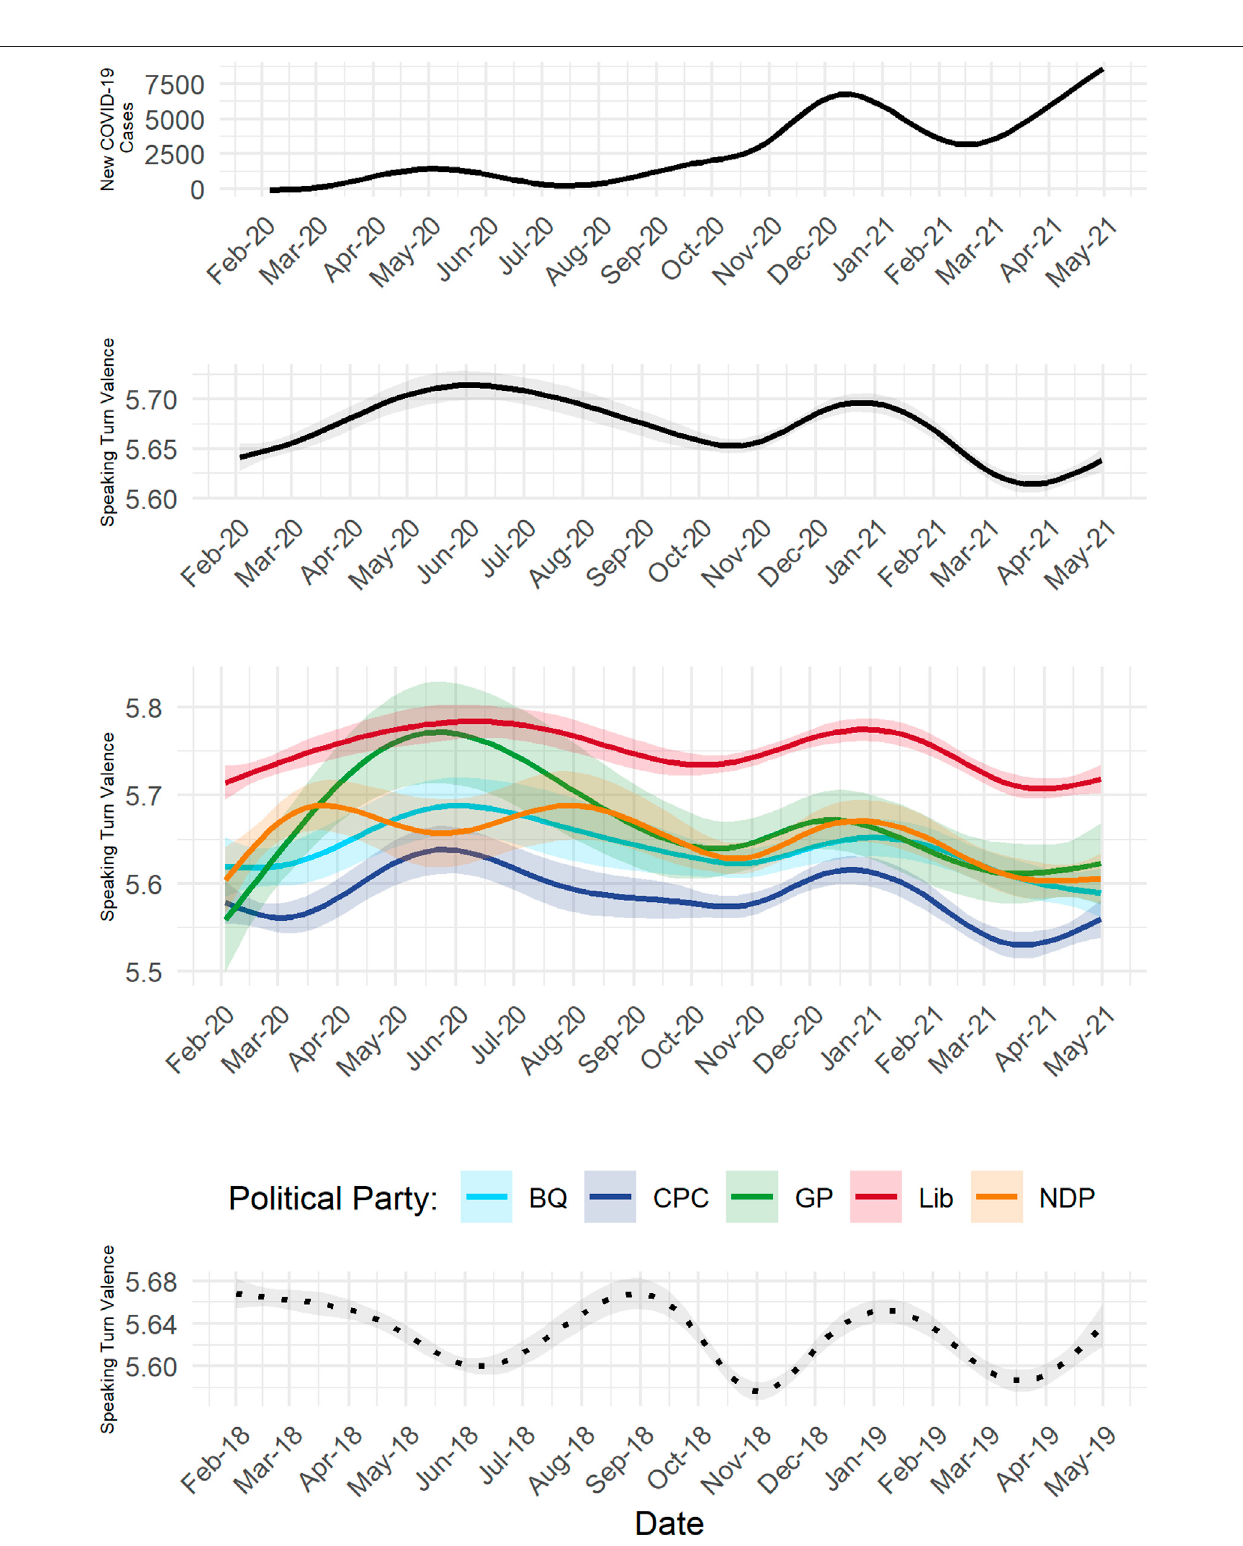
FIGURE4| Thetopthreeplotsdisplay(Top)thenumberofnewCOVID-19casesreportedinCanada,(Secondfromthetop)speakingturnvalence,and(Thirdfrom thetop) speaking turnvalence foreach represented Canadianpoliticalpartyover thecourseofthepandemicbymonth.Speakingturnvalenceestimates arebasedona generalized additive regression model with date as an independent ordinal variable. Shadowed areas above and below each line represent upper and lower 95% con fi dence intervals. The plot with the dotted line (Bottom) shows a comparison pattern for the same months in 2018 – 2019 (i.e., the comparable pre-COVID-19